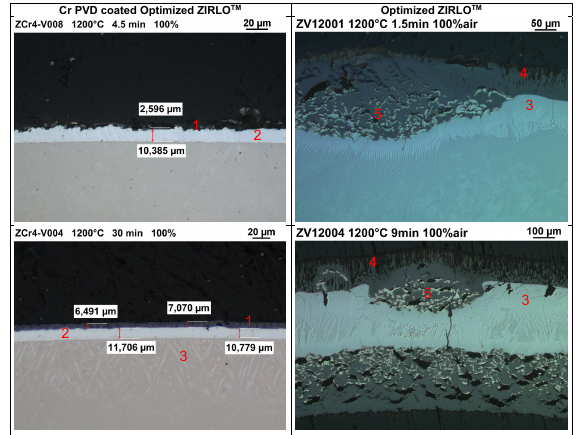
Figure 7. Microstructure after oxidation in air for Cr PVD coated sample oxidized for 4.5 and 30 minutes in comparison with uncoated sample oxidized for 1.5 and 9 minutes. (1. Outer Cr oxide 2. Remaining Cr